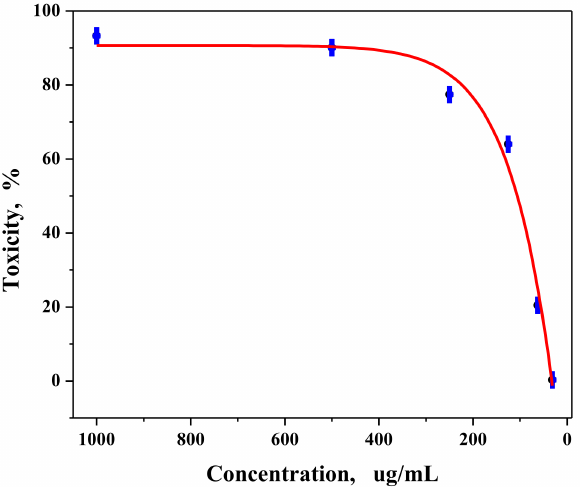
Figure 13. The toxicity of palladium nanoparticles on MCF-7 cells at various doses.